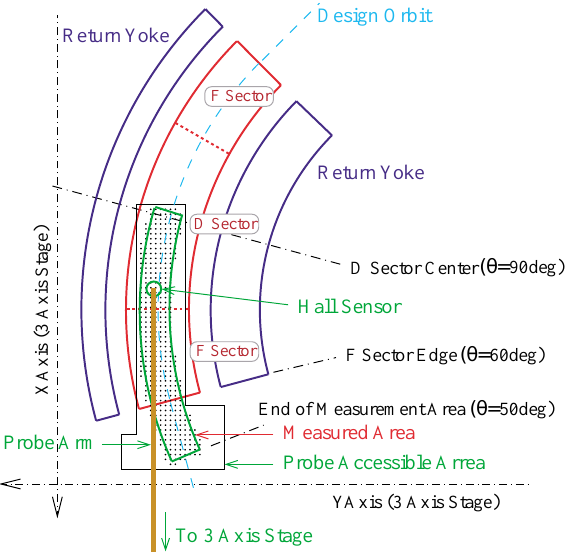
FIG. 9. (Color) Geometry of the measurement setup. The probe moves on a Cartesian grid in the “probe accessible area.” The measurement is achieved in the “measured area.”